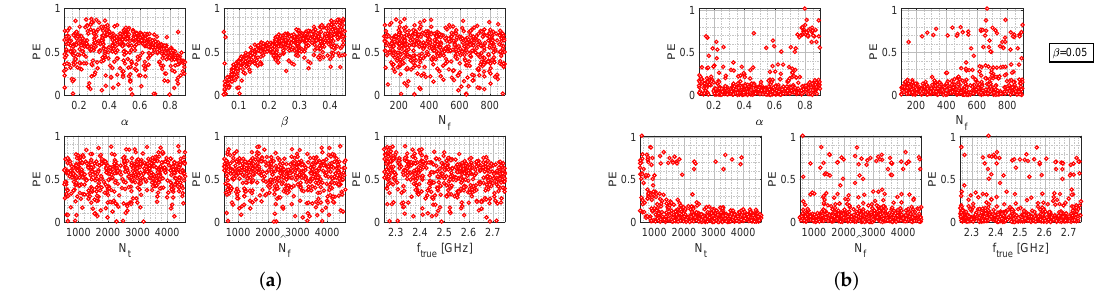
Figure 2. Performance evaluation of the single-step algorithm: ( a ) Scatter plots between PE and the various setting parameters, when the latter are all uniform random variables ( b ) Scatter plots between PE and the various setting parameters, when β = 0.05 and all other parameters are uniform random variables.